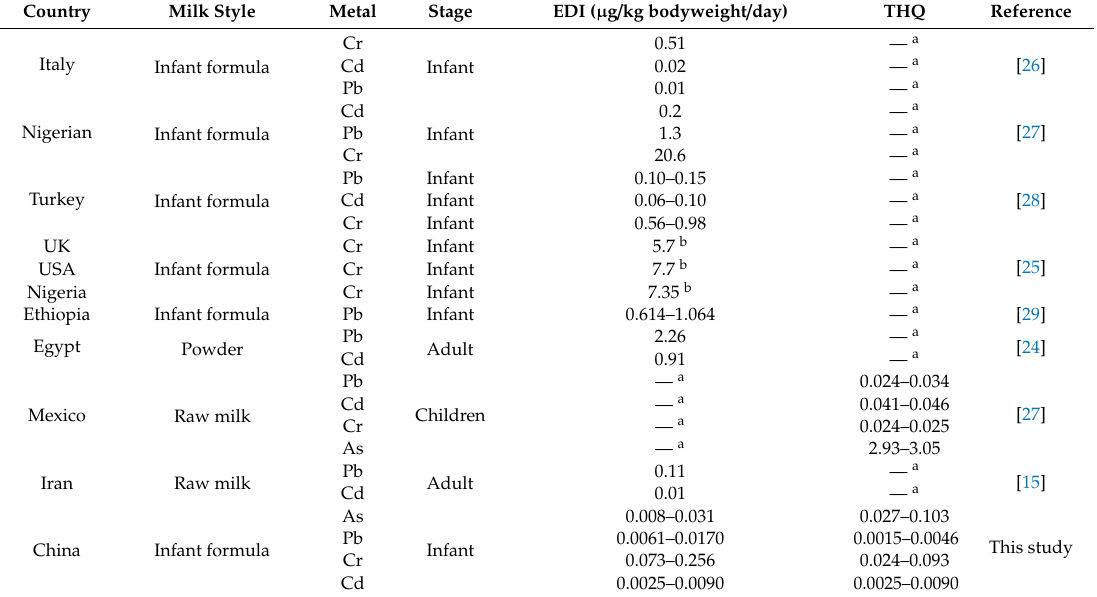
Table 8. EDI and THQ from other countries.